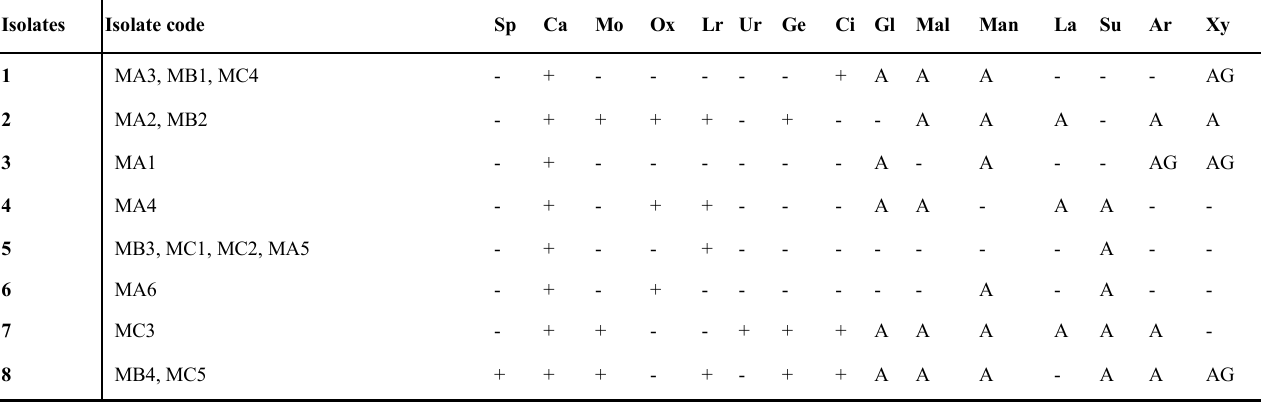
Table 3 : Biochemical characteristics of spore (Sp), catalase (Ca), motility (Mo), oxidase (Ox), litmus reaction (Lr), urease (Ur), gelatin (Ge), citrate (Ci), glucose (Gl), maltose (Mal), mannitol (Man), lactose (La), sucrose (Su), arabinose (Ar) and xylose (Xy) for studied bacterial isolates from soil contaminated with waste engine oil.